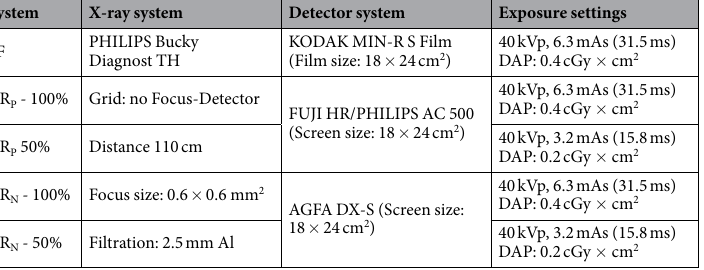
Table 1. Technical equipment and exposure settings used in the experimental setup. DAP: Dose Area